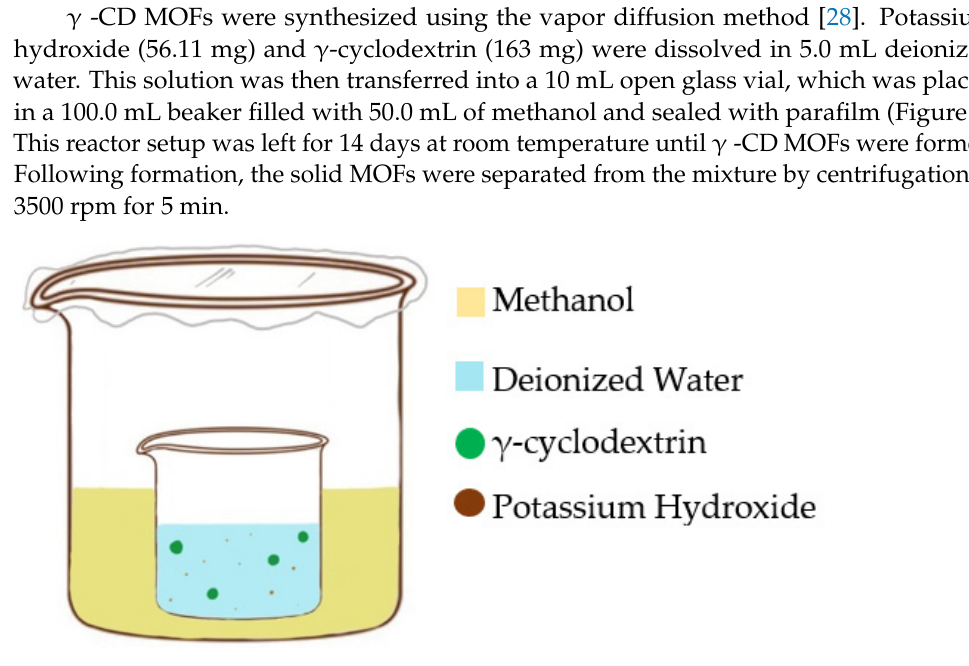
Figure 1. Schematic representation of vapor diffusion synthesis method of γ -CD-MOF .